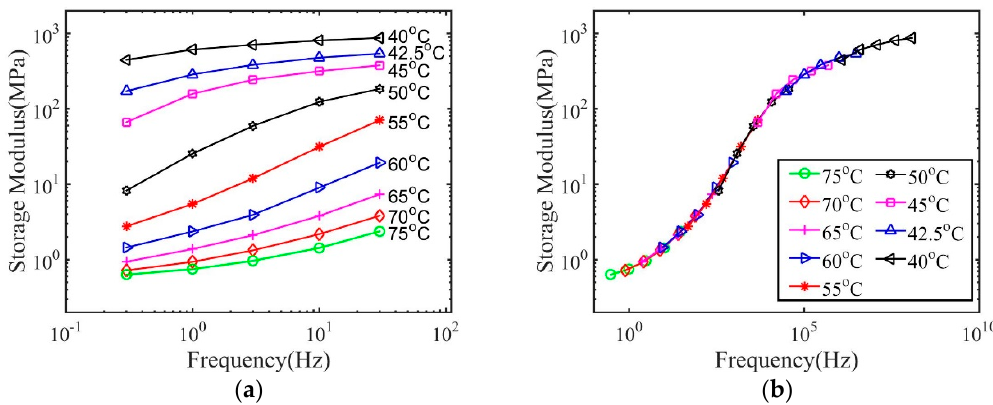
Figure 1. The storage modulus as a function of frequency for dry polymers with 2 wt.% crosslink density ( a ) measured at different temperatures, and ( b ) shifted to form a master curve.